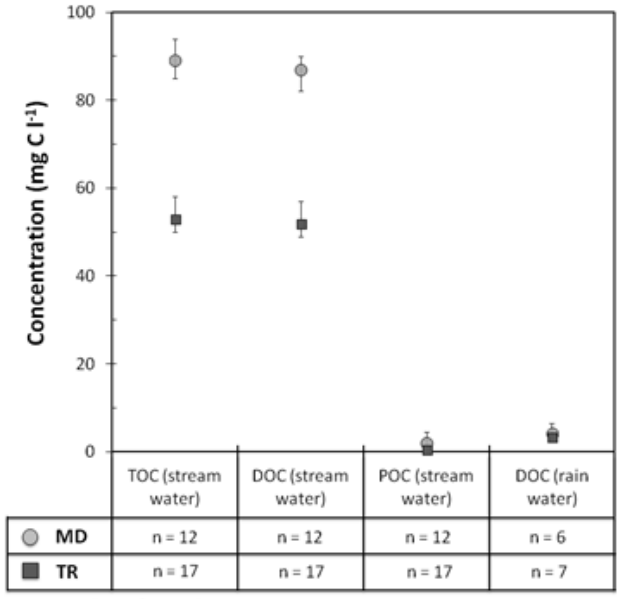
Figure 5. Organic carbon concentrations in Meranti Ditch (MD), Turip River (TR) and rainwater. Error bars indicate the maximum and minimum values observed.